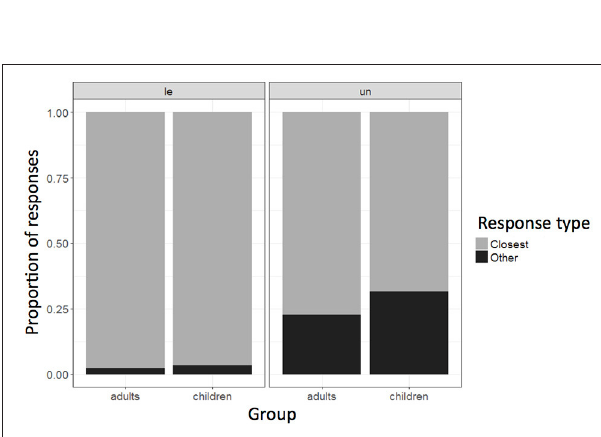
FIGURE 4 | Proportion of response types (closest vs. other) by GROUP (adults vs. children) and DEFINITENESS ( le, definite singular, vs. un , indefinite